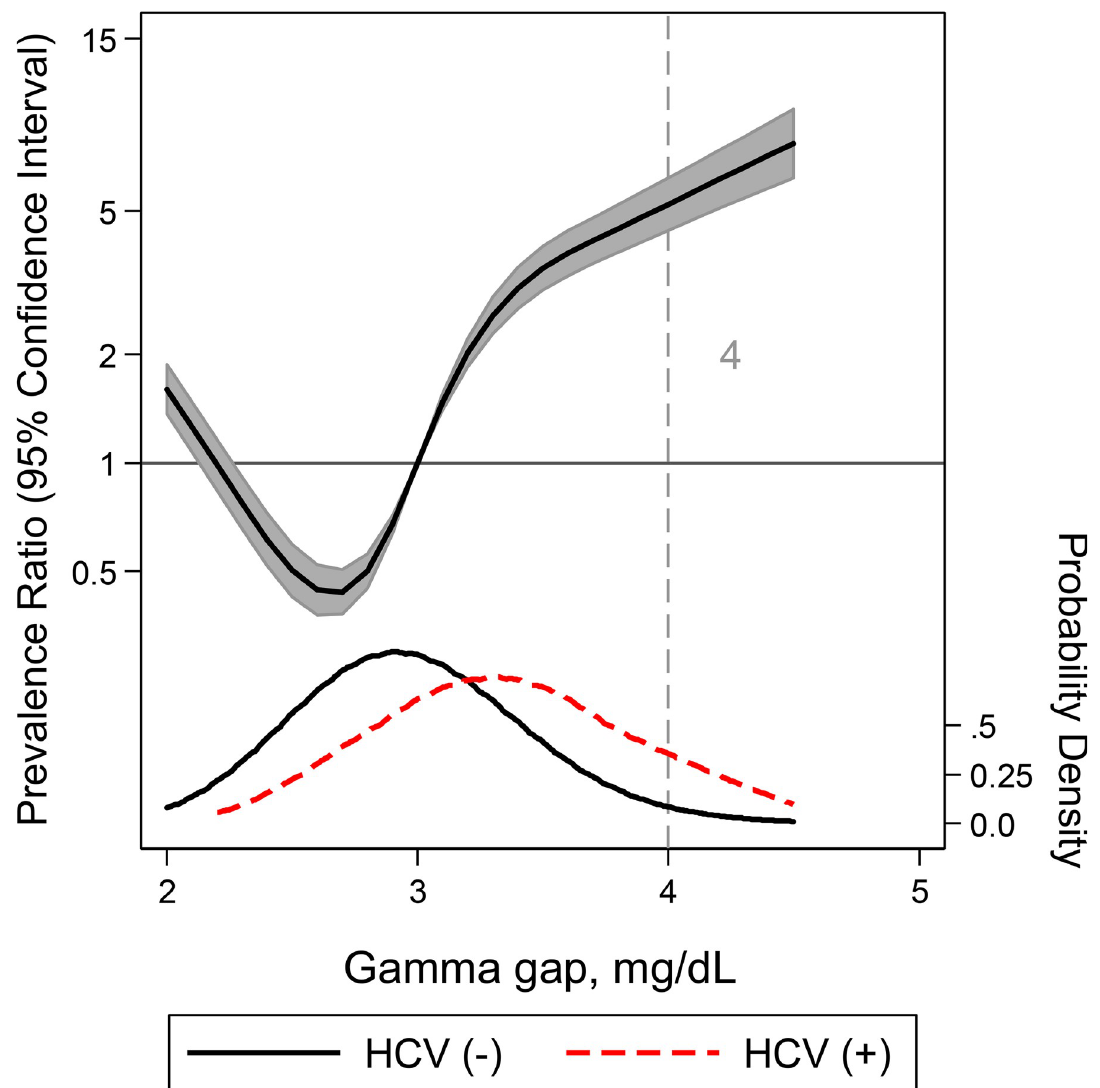
Fig 2. A restricted cubic spline model of the relationship between gamma gap and HCV adjusted for age, gender, and race with three knots. Adjusted prevalence ratio (solid line) and 95% CI were plotted against the gamma gap. Plot was truncated at the 0.5th and 99.5th percentiles. Gamma gap distribution in the case (positive for HCV) sample (red) compared to the control (negative for HCV) sample (black) are also included. The vertical grey line at 4g/dL indicates the commonly used gamma gap cutoff.